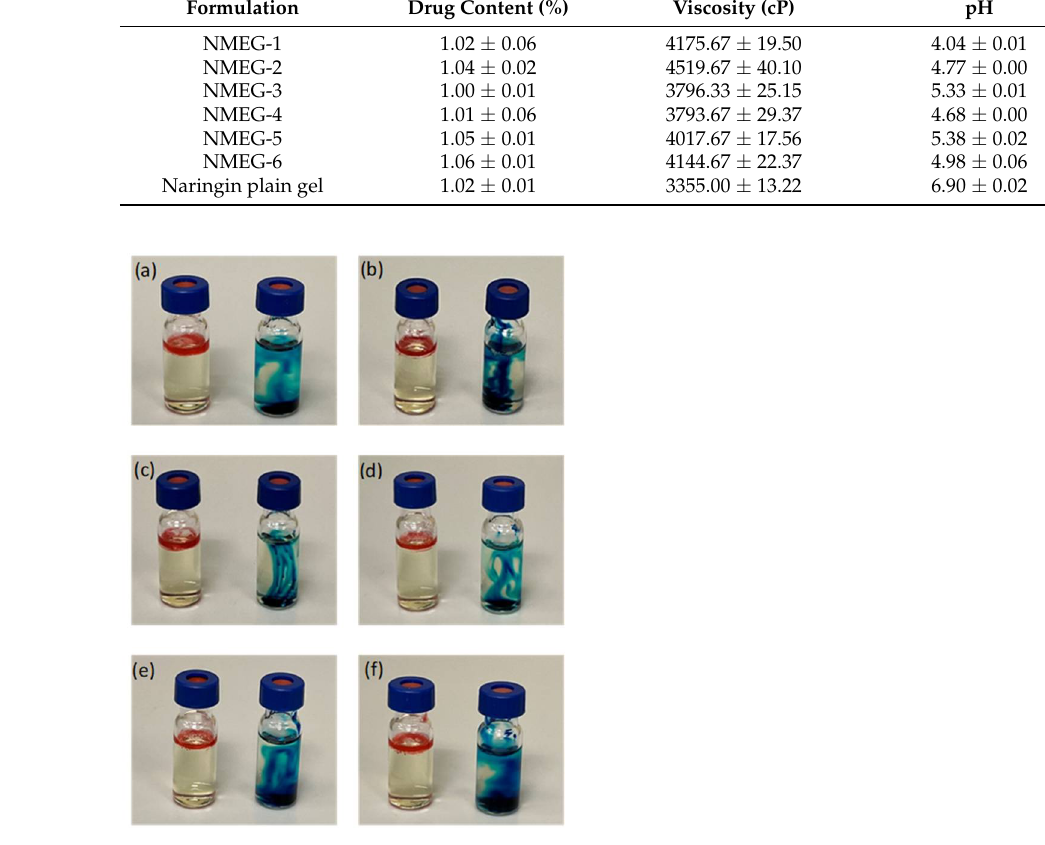
Figure 4. Diffusion behaviour of Sudan III (left) and methylene blue (right) in ( a ) NME-1; ( b ) NME-2; ( c ) NME-3; ( d ) NME-4; ( e ) NME-5 and ( f ) NME-6 after 5 minutes.